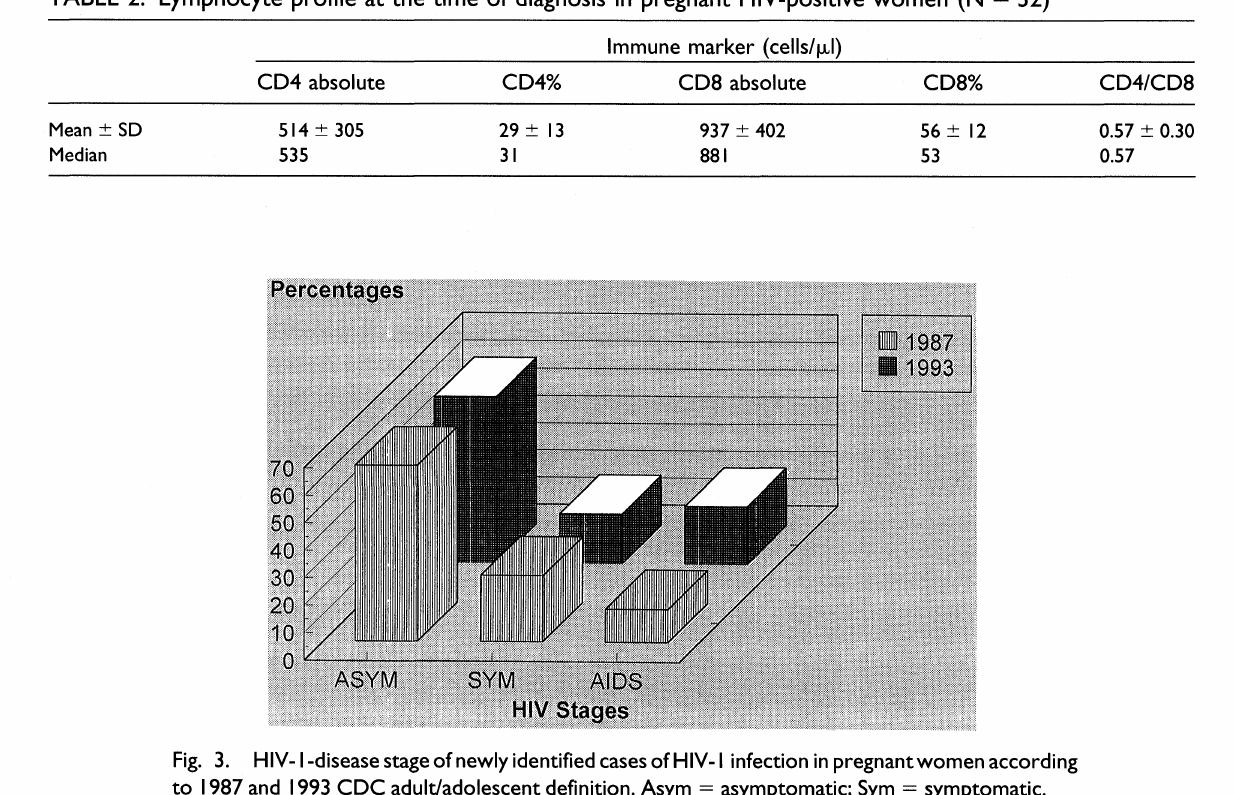
TABLE 2. Lymphocyte profile at the time of diagnosis in pregnant HIV-positive women (N